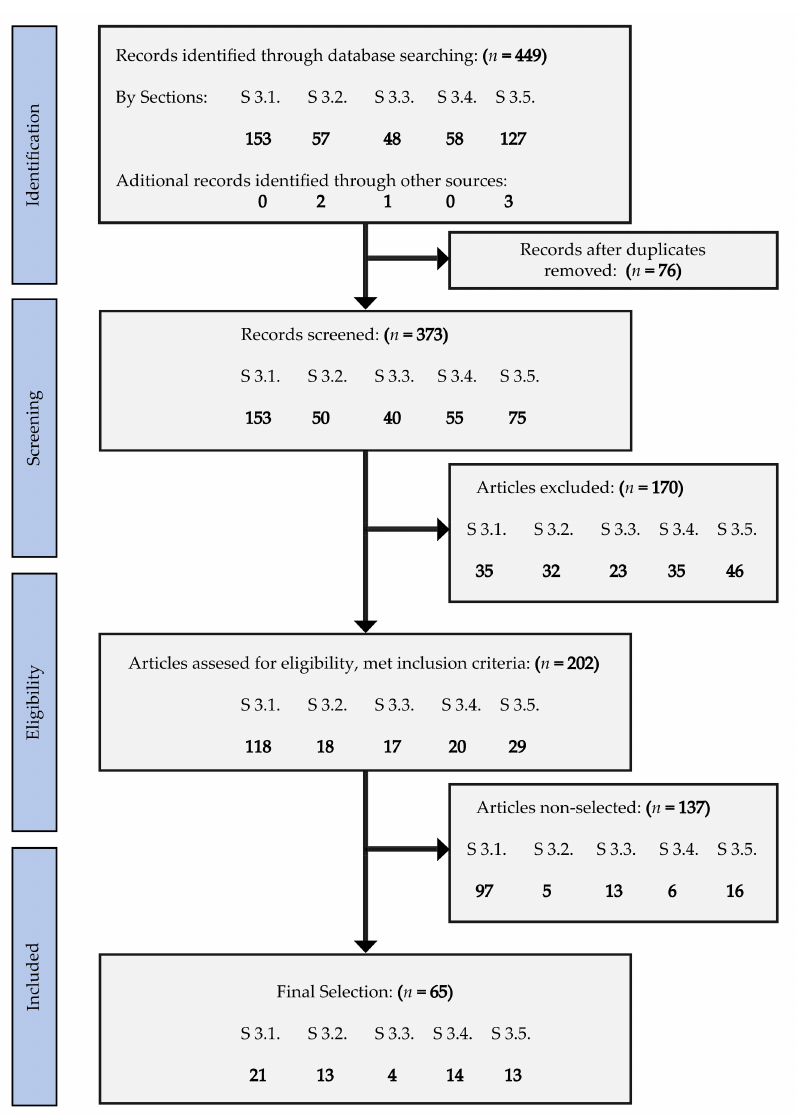
Figure 1. Methodological flowchart following the Preferred Reporting Items for Systematic Reviews and Meta-Analyses (PRISMA)